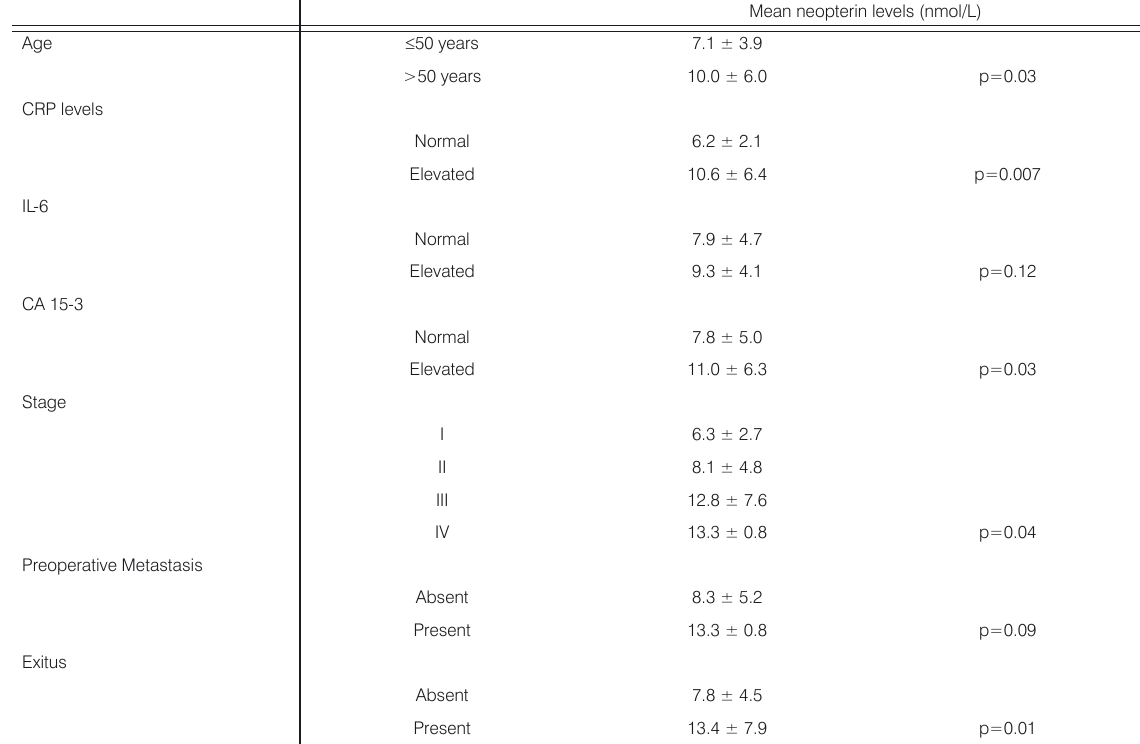
Table 2. Association of mean neopterin levels with different clinicopathological parameters.